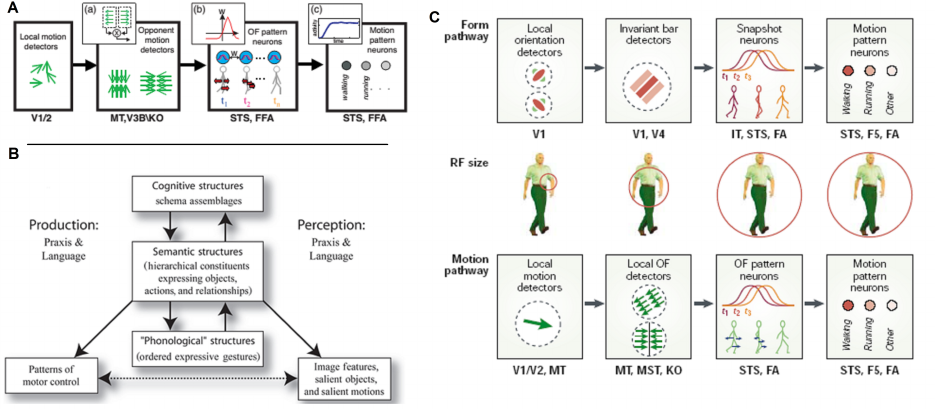
Figure 3. ( A) Schema of the model shown and symbols are shown following the brain areas and their functionality: MT: middle temporal area; V1: primary visual cortex; FFA: fusiform face area;